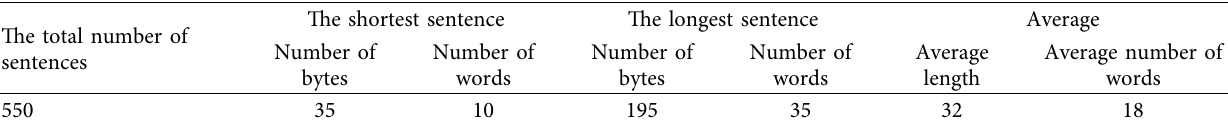
Figure 2: Distribution flowchart of adaptive local adjustment factors. Table 1: Sentence set